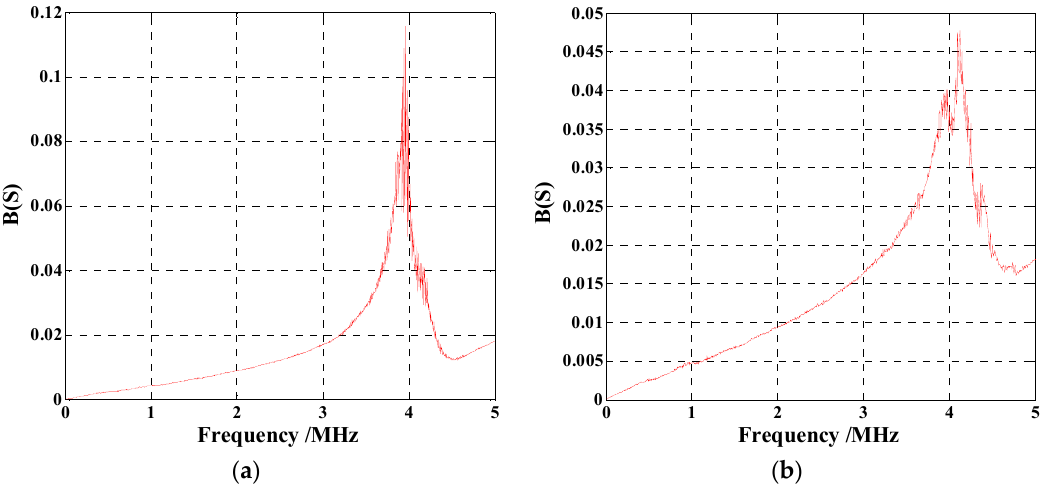
Figure 3. Susceptance changes with frequency of ( a ) M16; and ( b ) M12 bolts.